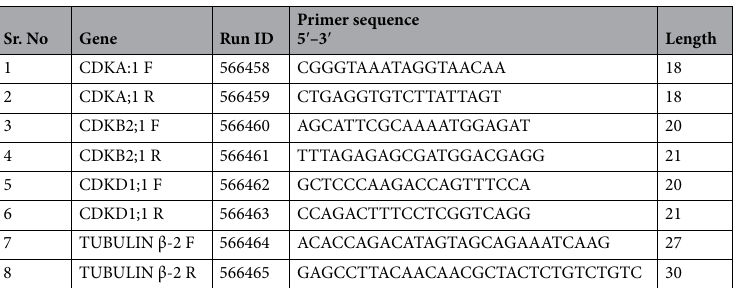
Table 2. Genes studied and tubulin as housekeeping gene: (names, Run ID (NCBI) and primers